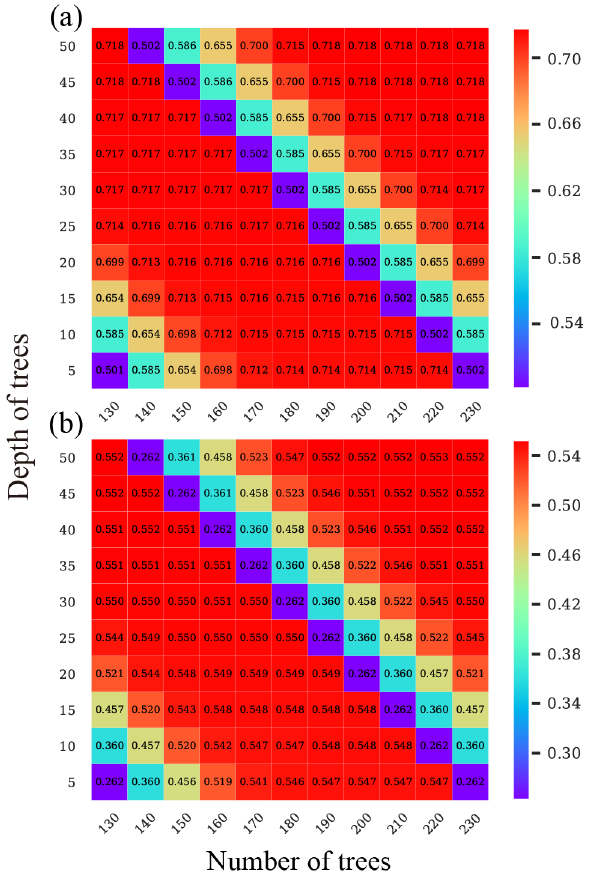
Figure 2. Out - of - bag score (OOBS) map of RF training model with different model parameters (number and depth of trees) for ( a ) channel 9 and ( b ) channel 10. The horizontal axis represents the number of trees, and the vertical axis represents the depth of trees. The sum of OOBSs is 1.